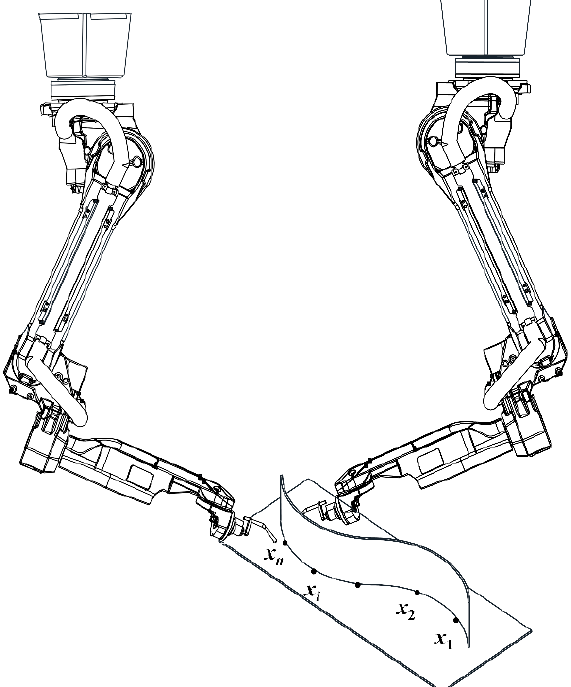
Figure 2. Schematic diagram of double-sided welding of welding robot.